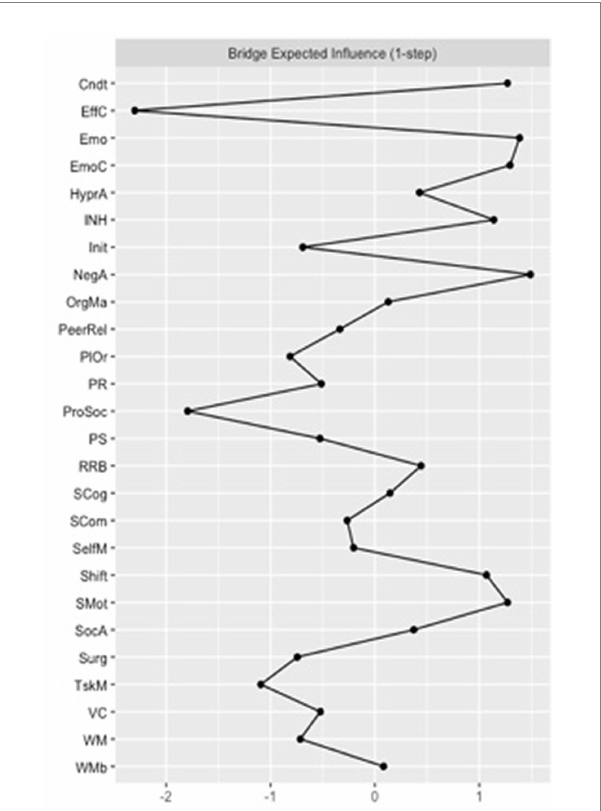
FIGURE 4 Bridge expected influence for the very preterm (VPT) group network. Cndt, conduct problems; EffC, effortful control; Emo, emotional problems; EmoC, emotional control; HyperA, hyperactivity; INH, inhibition; Init, initiating behaviors; NegA, negative affectivity; OrgMa, organizing materials; PeerRel, peer relationship problems; PlOr, planning and organizing; PR, perceptual reasoning; ProSoc, prosocial behaviors; PS, processing speed; RRB, rigid and repetitive behaviors; SCog, social cognition; SCom, social communication: SelfM, self- monitoring; SocA, social awareness: Surg, surgency; TskM, task monitoring; VC, verbal comprehension; WM, working memory; WMb, working memory measured by the